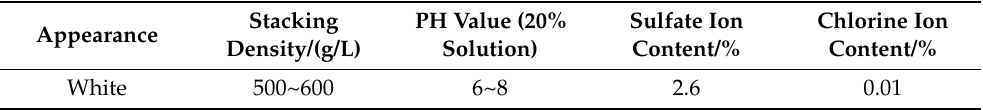
Table 3. Technical indexes of polycarboxylate acid